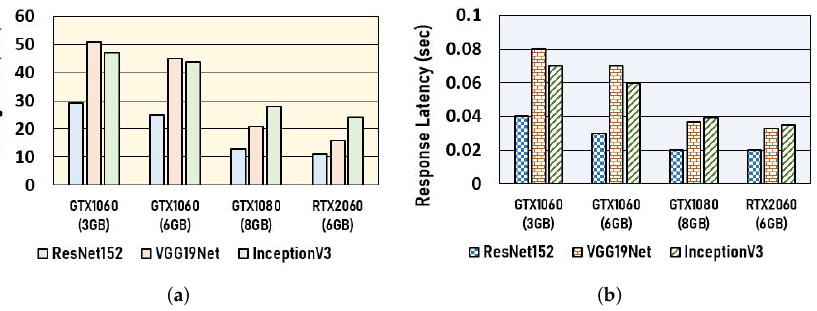
Figure 3. Deep learning (DL) ( a ) training time and ( b ) inference latency according to types of GPU